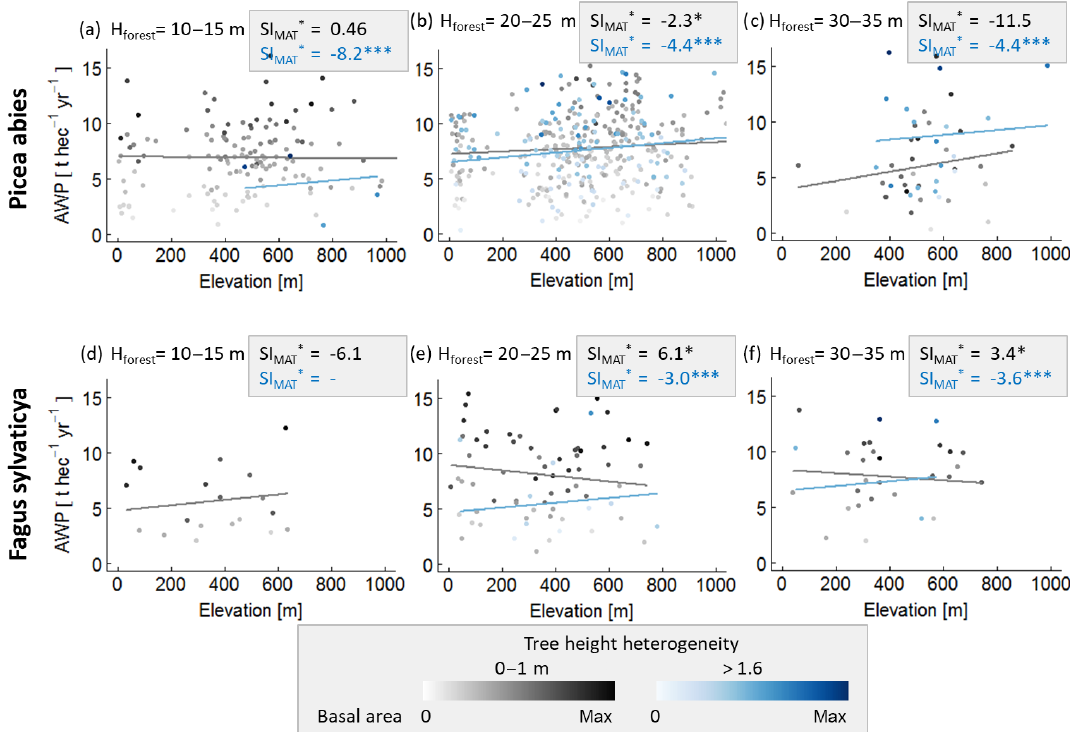
Figure A3. Analysis of the influence of forest structure on the relationship between elevation and AWP. Panels (a) – (c) are based on spruce monocultures and (d) – (f) on beech monocultures. For each species, forest stands were classified into three forest height classes which were based on the largest tree ( H max ) in a forest stand. These forest stand classes were additionally separated into two tree height heterogeneity classes (0–1m in grey and > 1 . 6m in blue). Intensities of the colours indicate the ratio between basal area of the stand and maximal basal area found within one class. Lines show the results of the linear model with mean basal area. The amount of stars behind the SI values indicates the significance of the slope within a linear model: ∗∗∗ indicates a p value below 0.001, and ( ∗ ) indicates a p value between 0.01 and 0.05. Absence of stars indicates p values above 0.1. The unit of SI ∗ is % ◦ C − 1 . MAT